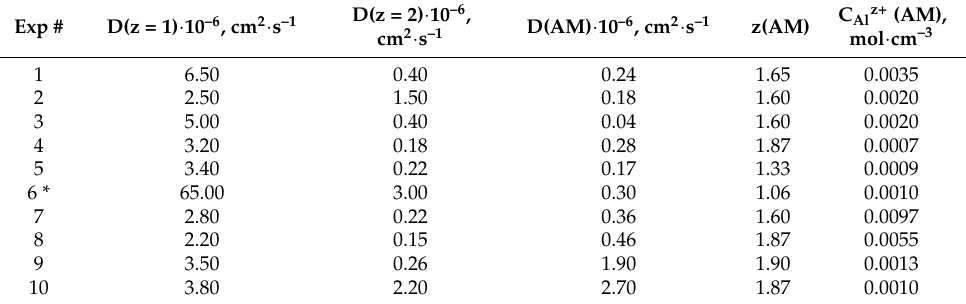
Table 3. Diffusion coefficients, number of electrons and concentration of Al z+ species calculated from the cyclic voltammetry and amperometry (AM)